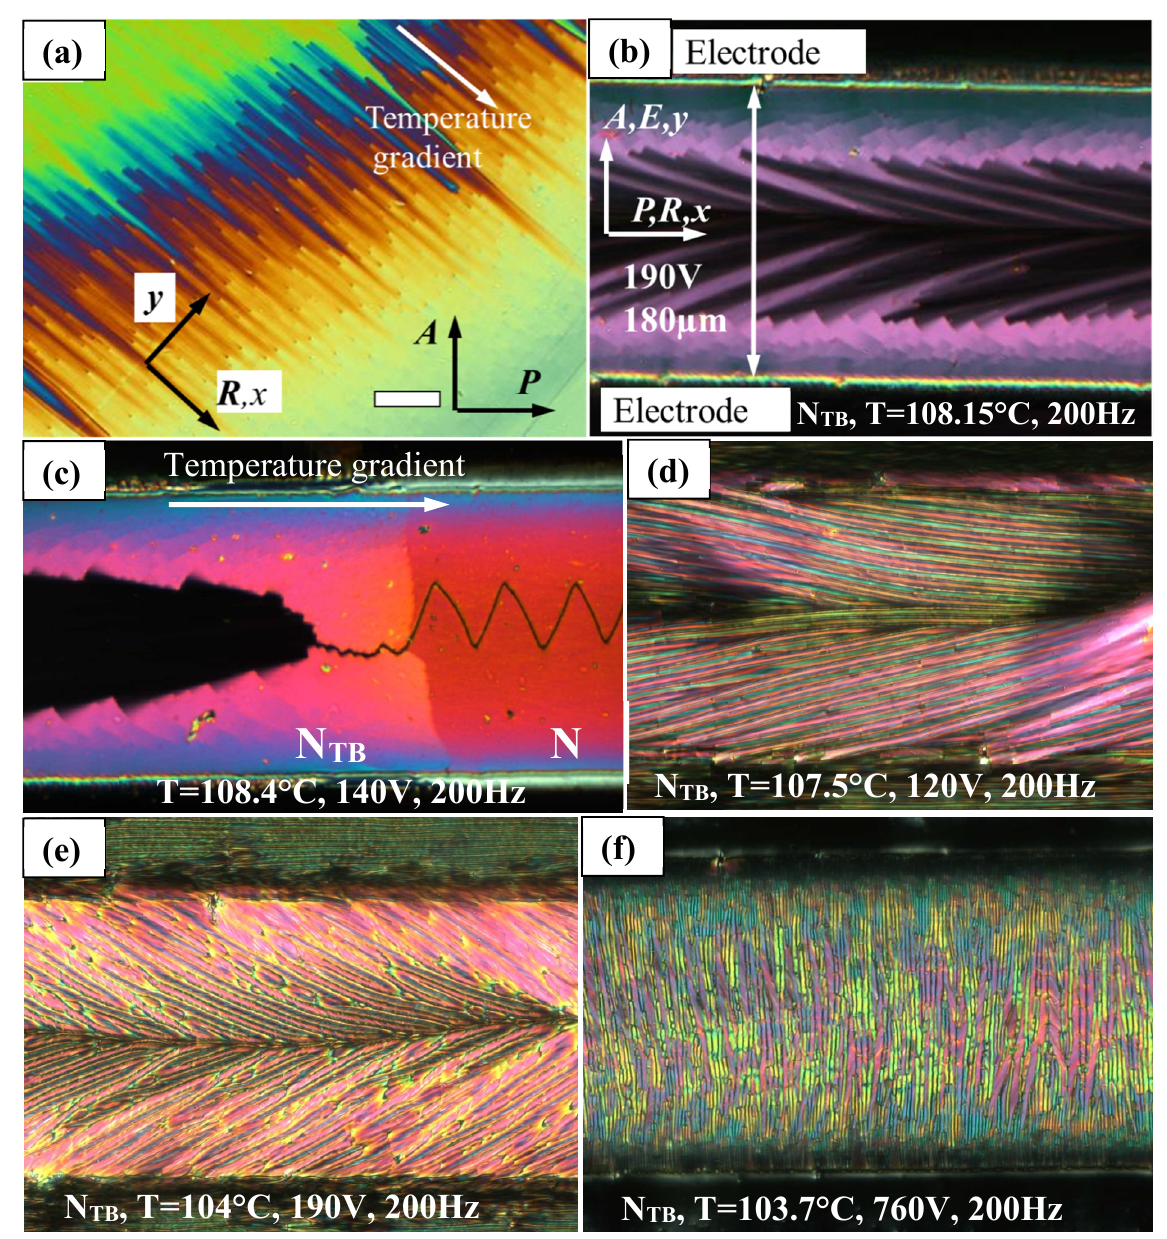
Figure 8. P and A refer to Polariser and Analyser, respectively. The material used is M1 having Δε > 0.8 ( a ) Fréedericksz transition in a temperature gradient cell. Bottom right—switched state, Top left—non-switched state. Note the sharp changes in the tone of colour between switched and non-switched states. These textures confirm the nature of the N–N TB transition: first order. A commercial planar cell of thickness 5µm is used, (EHC ® ) square wave of amplitude 4.5 V, frequency 1 kHz is applied. White bar length is 100 µm. Temperature 0.3 °C below the N–N TB transition temperature. ( b – f ) Cell with in-plane electrodes. The cell gap is 7 µm, antiparallel rubbing is normal to the electric field, distance between the electrodes is 180 µm. ( b ) 0.3 °C below the N–N TB transition. Sharp changes between the switched and non-switched states are visible like those in a planar-aligned cell shown in ( a ). ( c ) N–N TB transition under electric field with a small temperature gradient in the cell is demonstrated here. Note that a sharp increase in the threshold voltage observed in the N TB phase and disclination lines in the middle of the cell are different in the two phases. ( d ) The cell is cooled to temperatures of the striped N TB while voltage is applied across the cell. The stripes are formed at an angle to the rubbing direction. ( e ) Higher voltage leads to stronger deviation of the striped pattern from the rubbing direction. ( f ) The cell is completely switched by the extremely large electric field applied—consequently, the stripes are parallel to the field direction; however, the competition between the surface alignment and the electric field distorts the pattern, making it rather similar to that exhibited by a twisted cell discussed later.